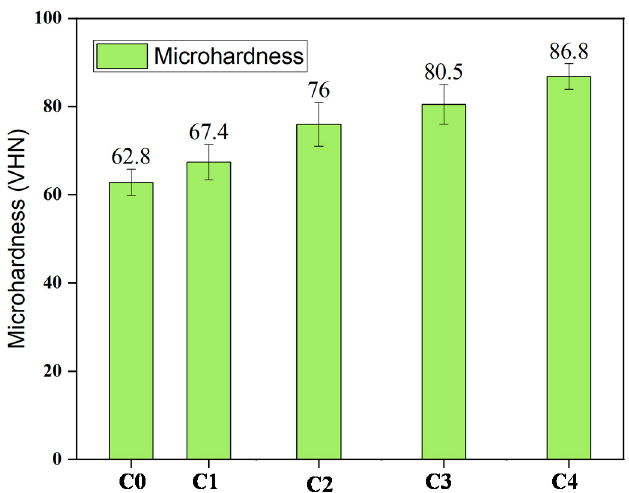
Figure 13. Effect of combined mixing time on the Vickers microhardness of synthesized composite samples.